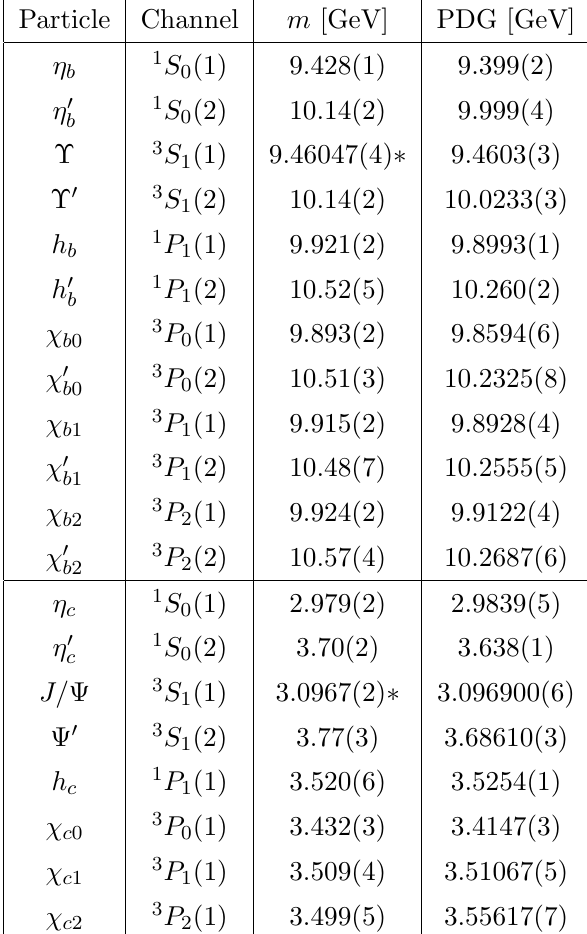
Table 4 . Mass estimates for the ground and (cid:12)rst excited states of bottomonium and charmonium at zero temperature from the BR method, compared to the experimental PDG values. While the S-wave ground state values agree with the results from the e(cid:11)ective mass (cid:12)t, the P-wave results from the BR method lie slightly closer to the correct values. A possible reason is the higher (cid:13)exibility of the BR method to disentangle ground and excited states